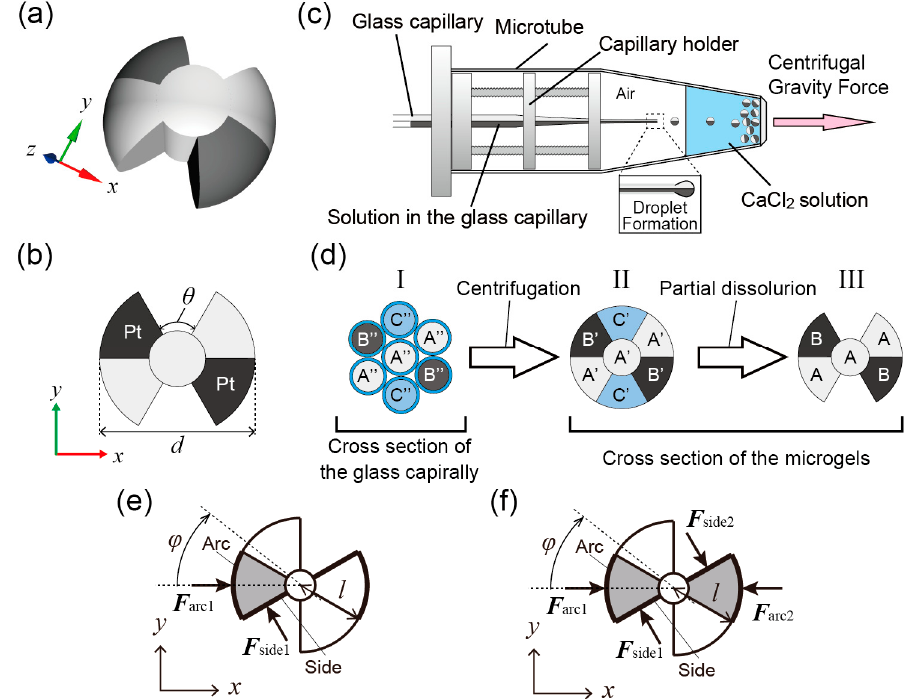
Figure 1. Schematic illustrations of the propeller-shaped micromotor and synthesizing methods. ( a ) 3D sketch of the micromotor; ( b ) 2D sketch of the micromotor with diameter d ~140 µ m and an angle of propeller θ ~50 ◦ ; ( c ) Schematic illustrations of centrifuge-based droplet-shooting device (CDSD); ( d ) Synthesizing diagram of the propeller-shaped micromotors. A cross sectional image of the glass capillary (I), the spherical microparticles (II) and the propeller-shaped micromotors with PtNPs (III) are shown; ( e , f ) Designs of a propeller-shaped micromotor used in our experiments and numerical simulation with a single catalytic site ( e ) and with double catalytic sites ( f ).